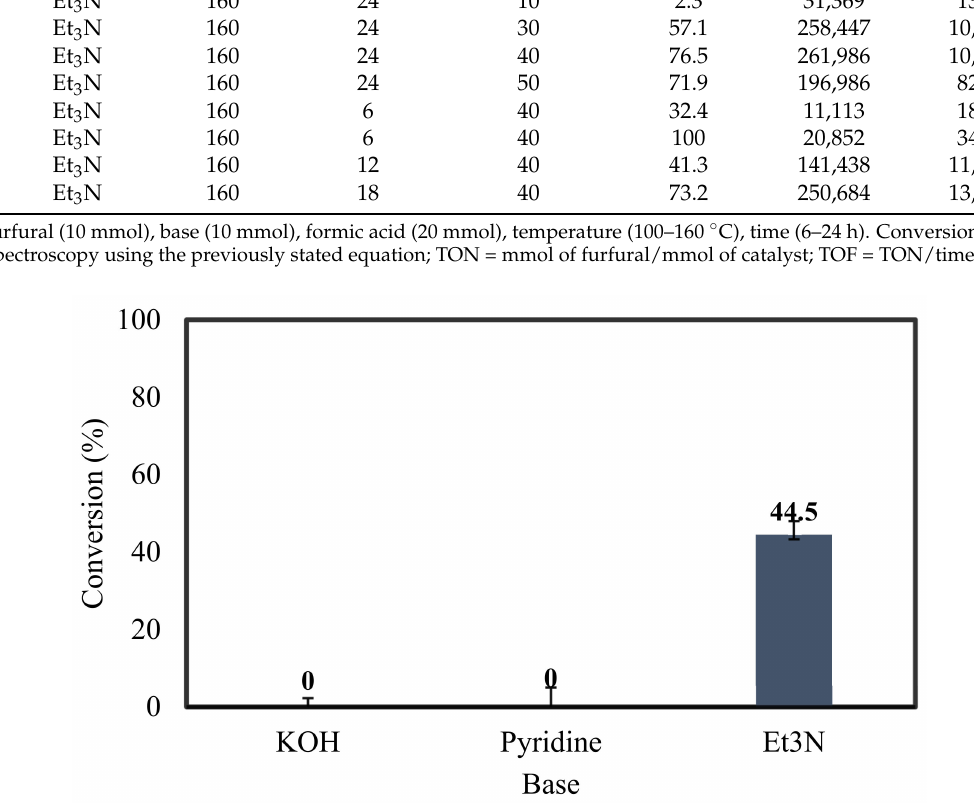
Figure 9. Conversion of furfural as a function of base. Conditions: furfural (10 mmol), base (10